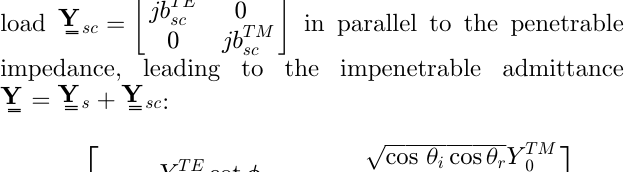
ffiffiffiffiffiffiffiffiffiffiffiffiffiffiffiffiffiffiffiffiffiffiffiffi p cos u